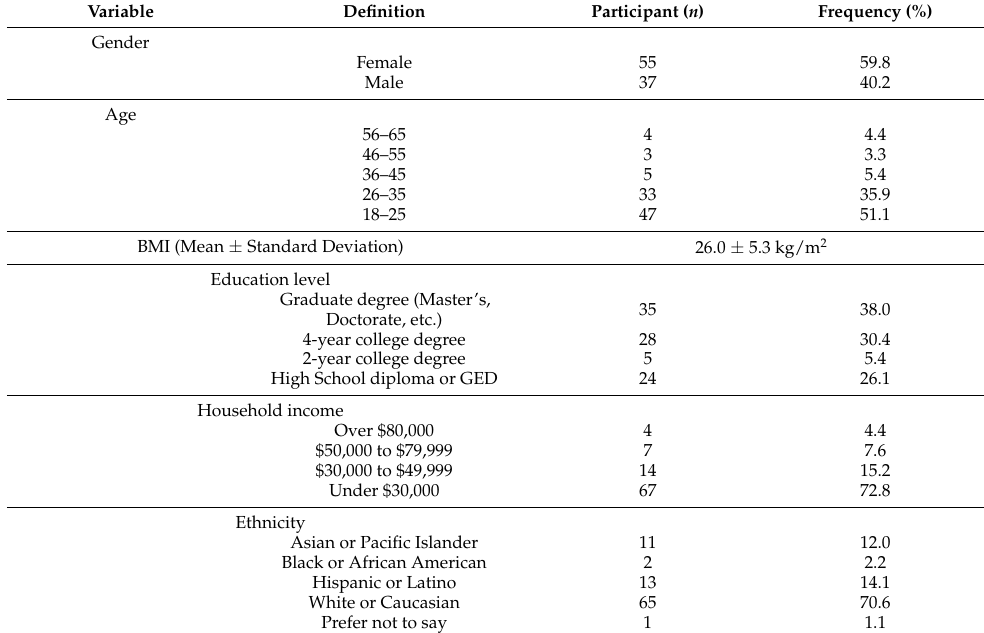
Table 2. Demographic and socioeconomic characteristics of the consumer panelists ( n = 92).